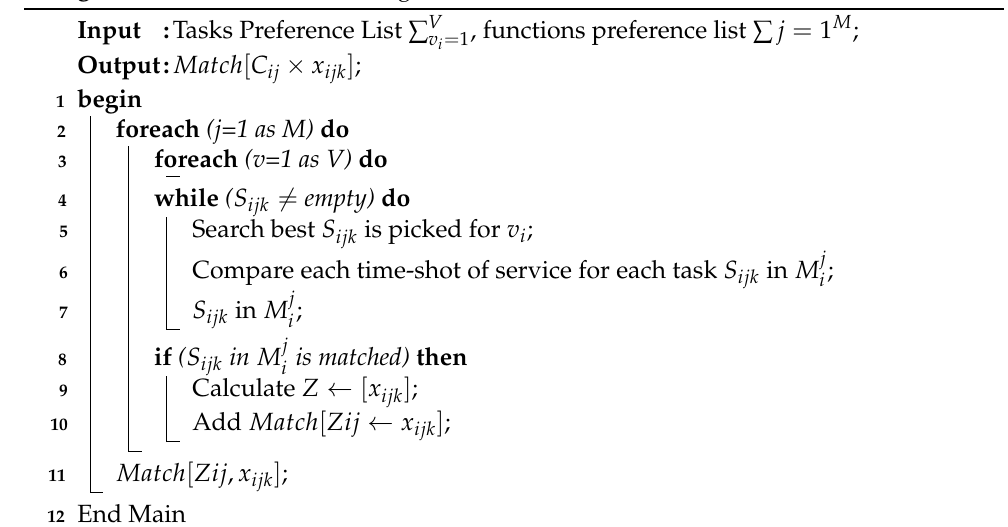
Algorithm 3: Resource